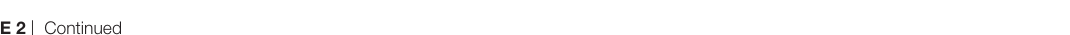
FigUre 2 | Continued Lipid rafts are important in the process of systemic lupus erythematosus (SLE) IgG-induced differentiation of monocytes into dendritic cells (DCs). (a) Confocal microscopy analysis of lipid raft clustering using FITC-conjugated CTB in monocytes cultured with SLE serum or medium control for 3 and 48 h. The arrows represent typical clustered lipid rafts. (B,c) Representative photographs of monocytes cultured with SLE serum with or without methyl- β -cyclodextrin (M β CD) for 48 h (B) or SLE IgG with or without M β CD for 48 h (c) . Original magnification 20 × and the arrows represent typical differentiation of monocytes into DCs. (D) Immunohistochemical staining for CD64 (Fc γ RI) expression in skin lesions of C57BL/6 mice 3 days after intradermal inoculation of SLE serum. The arrows represent CD64 + cells. (e) Confocal microscopy analysis of colocalization of CD64 and lipid rafts in monocytes cultured with medium control, SLE IgG, SLE IgG, and M β CD for 3 h. The arrows represent the cells which were analyzed. (F) Western blot analysis of expression of p-NF- κ B p65/NF- κ B p65 and GAPDH in Raw264.7 cells treated with medium control, SLE IgG, SLE IgG + M β CD, or M β CD for 30 min. (g,h) CBA-measured levels of MCP-1 or TNF α in supernatants